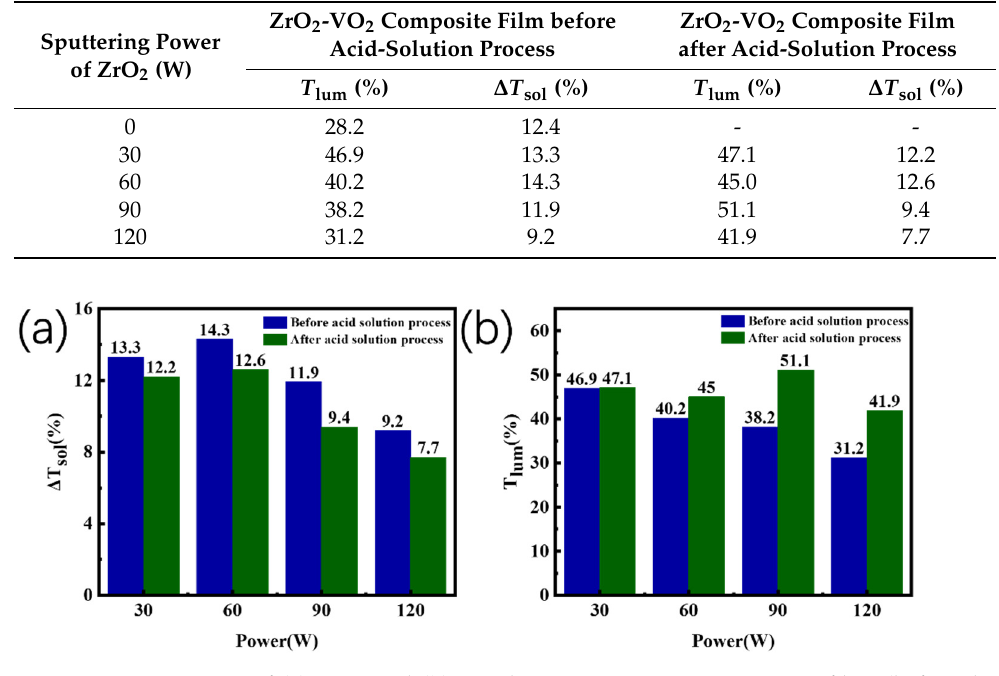
Figure 5. Comparison of ( a ) ∆ T sol and ( b ) T lum between ZrO 2 -VO 2 composite films (before the acid-solution process) and island-like ZrO 2 -VO 2 films (after the acid-solution process) with different sputtering powers of the ZrO 2 target. Table 2. The solar-modulation efficiency ( Δ T sol ) and visible transmittance ( T lum ) of the obtained films.